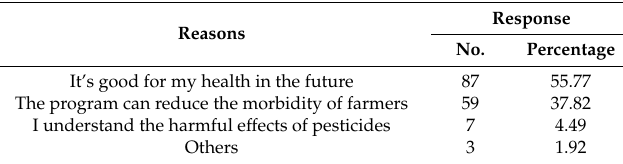
Table 2. Reasons for saying “yes” to the WTP question.